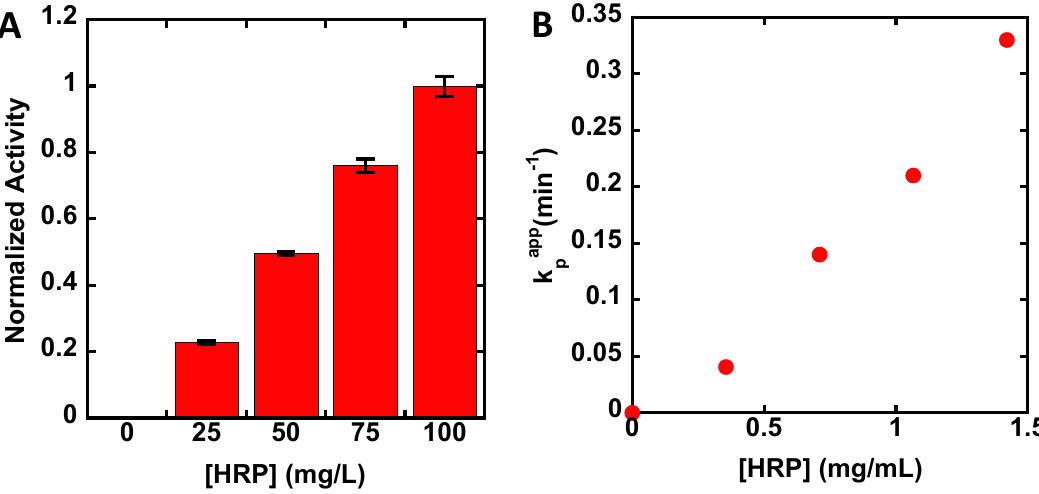
Figure 5. ( A ) Relative rate of enzymatic activity, as a function of HRP loading, measured by the reaction of aminoantipyrine and phenol, normalized to activity at 100 mg/L HRP loading, ( B ) Apparent polymerization rate (k papp ) under the conditions: [DMAm] 0 :[PAETC] 0 :[ACAC] 0 :[H 2 O 2 ] 0 = 100:1:9.7:1.7, [DMAm] = 170 mM, [HRP] = X mg/mL in 4.2 mL of pH = 5.5, 20 mM acetate buffer at 25 °C.